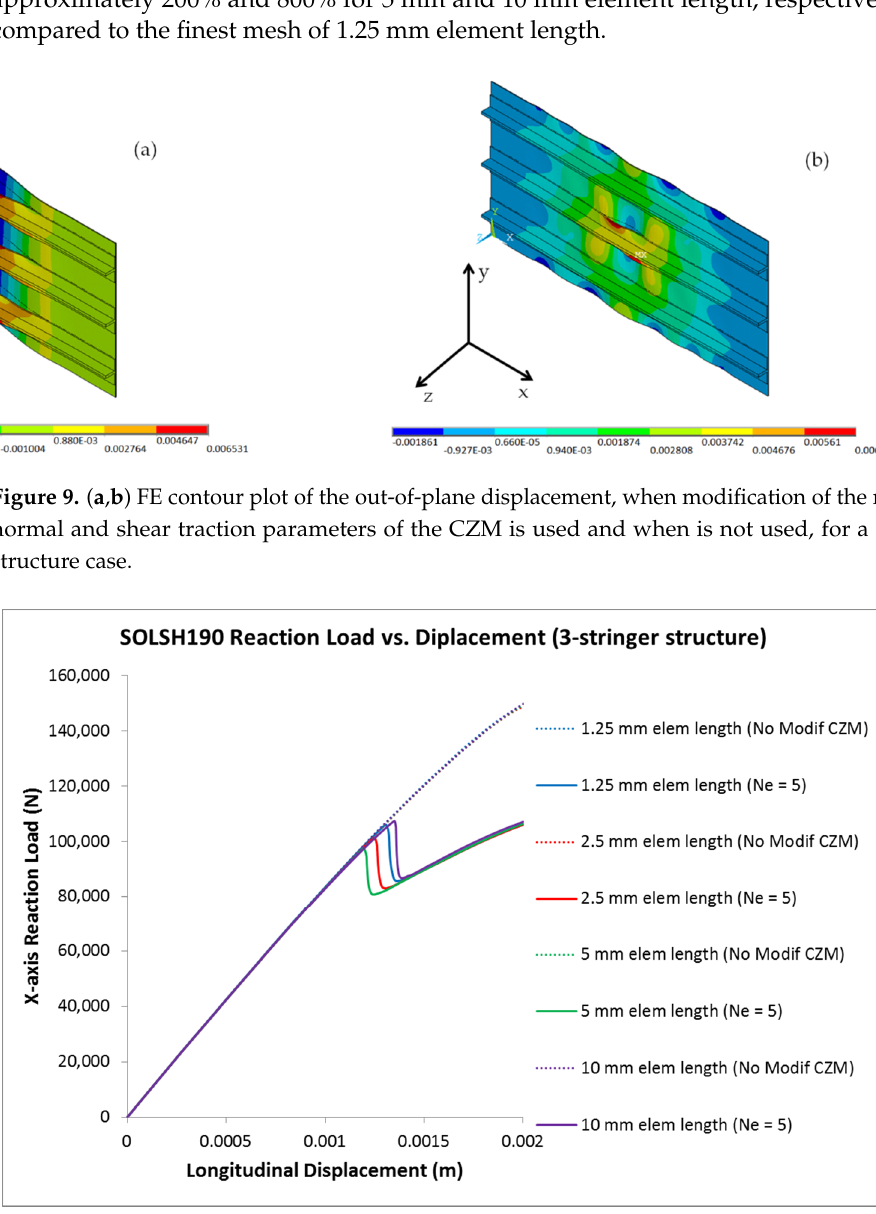
Figure 10. Load–displacement curves of the 3-stringer structure for element type SOLSH190.